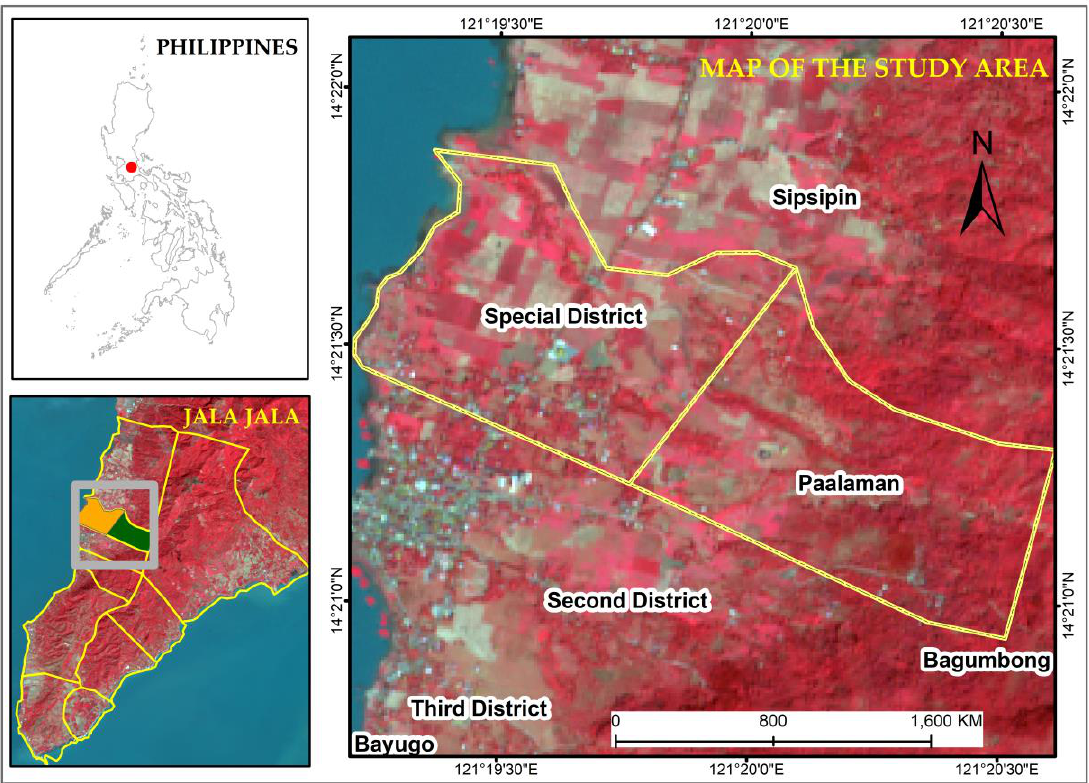
Figure 1. Location of Laguna de Bay Basin and the study areas.